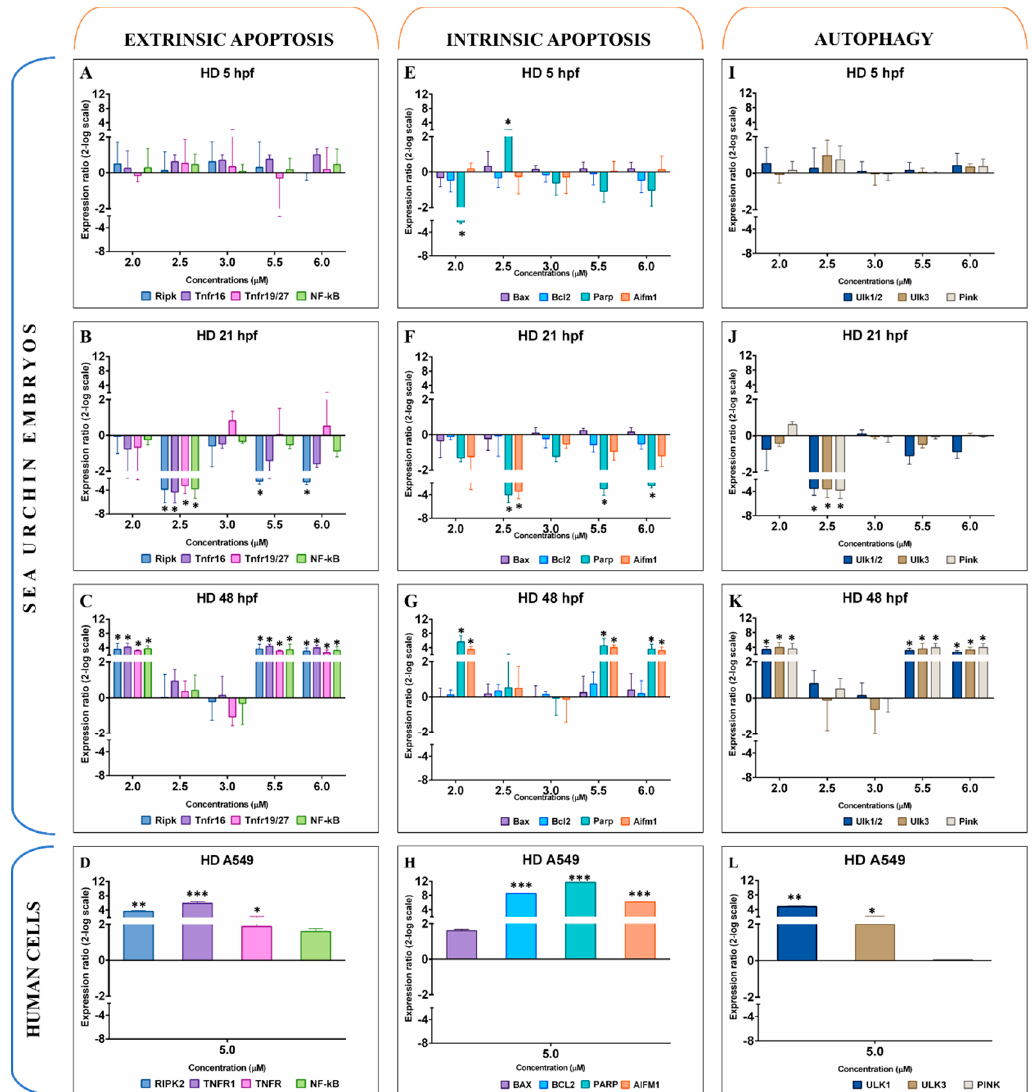
Figure 2. Gene expression levels of 11 genes belonging to extrinsic apoptosis ( A – D ), intrinsic apoptosis ( E – H ), and autophagy ( I – L ) in the sea urchin Paracentrotus lividus treated with 2.0, 2.5, 3.0, 5.5, and 6.0 μ M of heptadienal for 5, 21, and 48 hpf and in A549 human cells treated with 5.0 μ M for 2 h. Samples obtained from three independent biological replicates were analysed by qPCR in technical triplicates. Data are reported as fold difference (mean ± SD), compared to controls without heptadienal. Error bars represent the variation in biological replicates. Expression values were statistically analysed by Mann–Whitney U test and values were considered significant if the p -value was <0.05 (* for p -value <0.05; ** for p -value <0.01; *** for p -value <0.001).